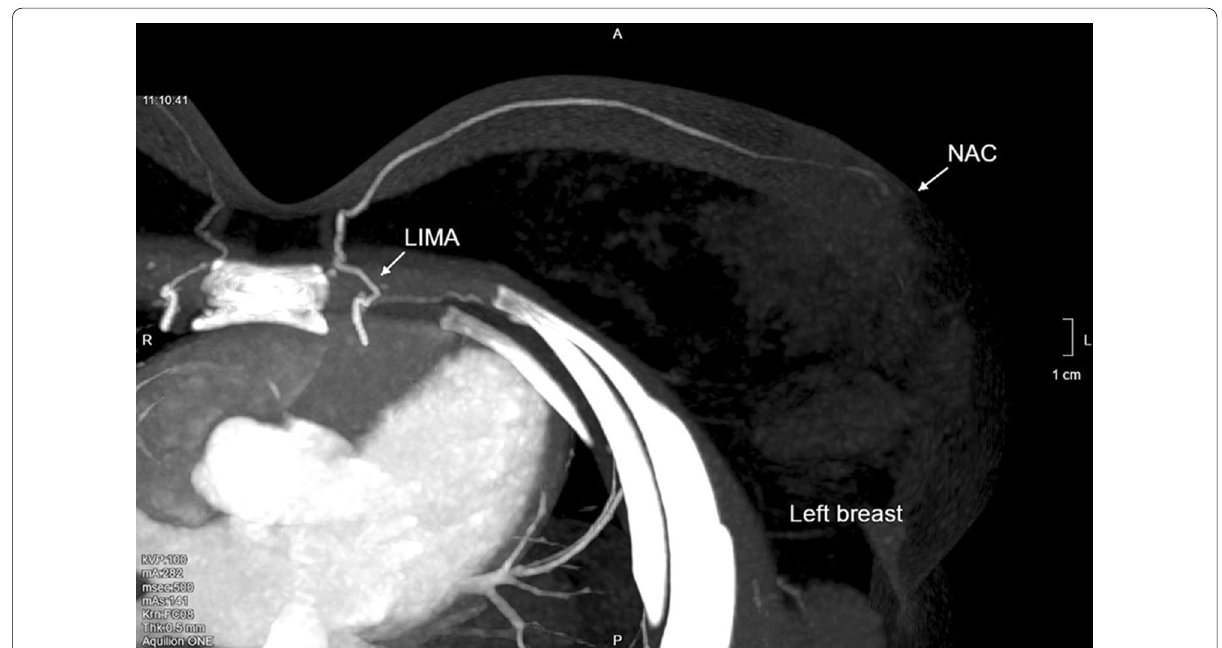
Fig. 3 MIP image demonstrating dominant arterial supply to NAC. A thick-slab axial MIP image of the left breast can trace dominant arterial supply to NAC arising from LIMA till it reaches NAC within single image